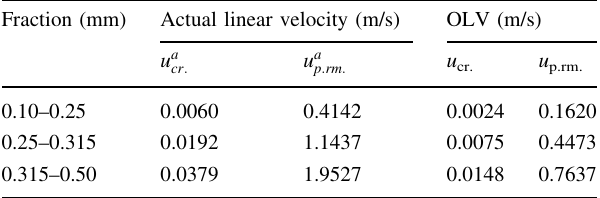
Table 7 Calculated values of oxidant linear velocity for different fractions of the investigated coal Fraction (mm) Actual linear velocity (m/s)